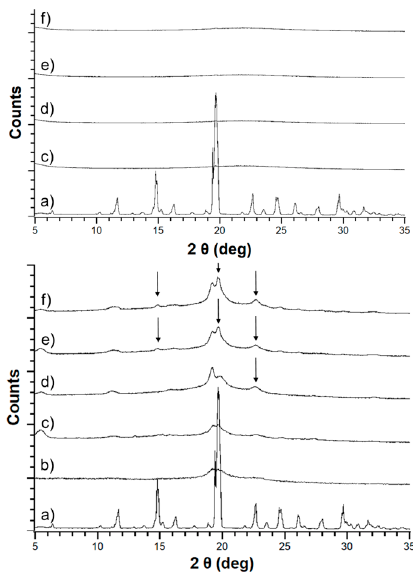
Figure 5. PXRD patterns for haloperidol loaded silica (top) and haloperidol HME (bottom) showing crystalline haloperidol (a), pure PVA (b), unstressed haloperidol formulation (c) and stressed haloperidol formulations at 30 (d), 60 (e), and 90 (f) days. The arrows indicate crystalline peaks in the diffractograms.